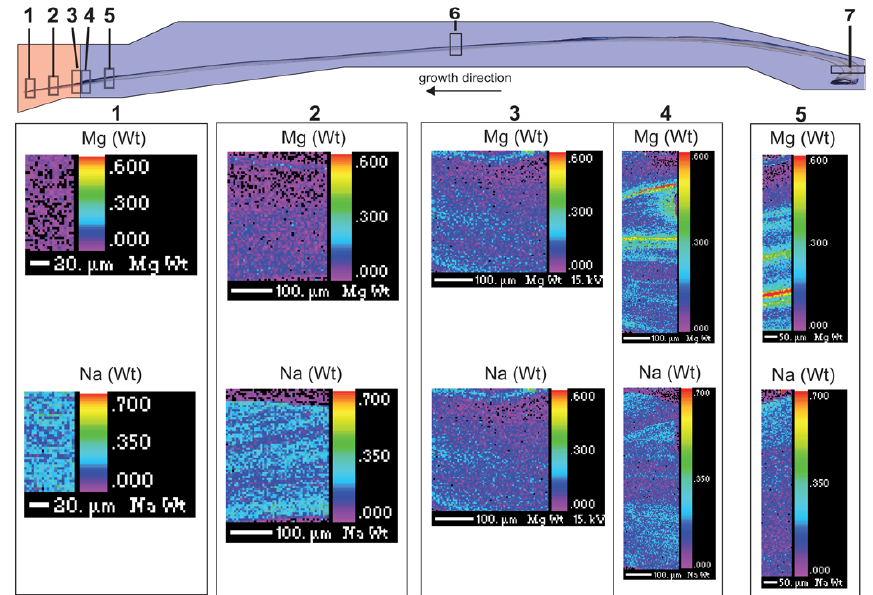
Fig. 7. Thin section view of M. galloprovincialis from acidified experimental site B1. Blue colour indicates shell precipitated prior to transplantation and red colour indicates shell precipitated after transplantation. Gray boxes numbered 1 through 7 indicate the position of the microprobe maps. The maps 1 to 5 were measured across the calcitic shell layer only. Maps 6 and 7 are shown in Fig. 8 and are located at the mid-shell and the hinge. Map 6 was measured across the calcitic and aragonitic layers, map 7 was measured across the aragonitic layer. Magnesium and sodium microprobe maps 1 through 5 are numbered in ascending order from the commissure to the hinge (corresponding to the boxes with the microprobe maps). Due to the incisive difference between the element magnesium (Mg) and sodium (Na), these elements are illustrated. The concentration of elements is given in weight percent (Wt). The element distribution in the shell displays no discernible pattern while concentrations of Mg and Na follow opposite